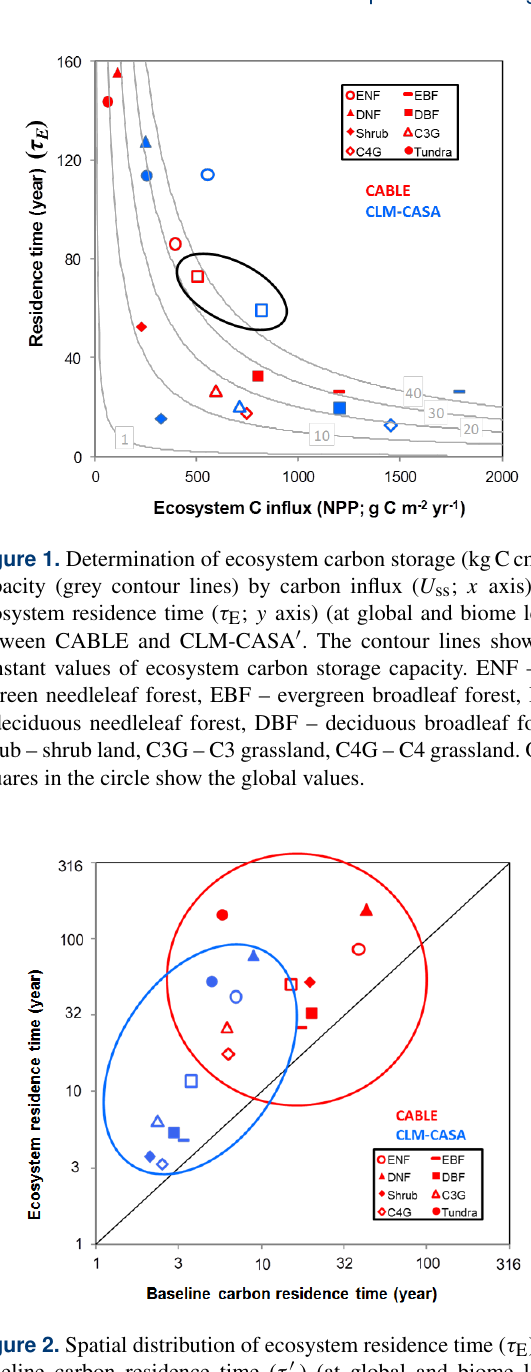
were taken from IGBP-DIS data set (IGBP-DIS, 2000).